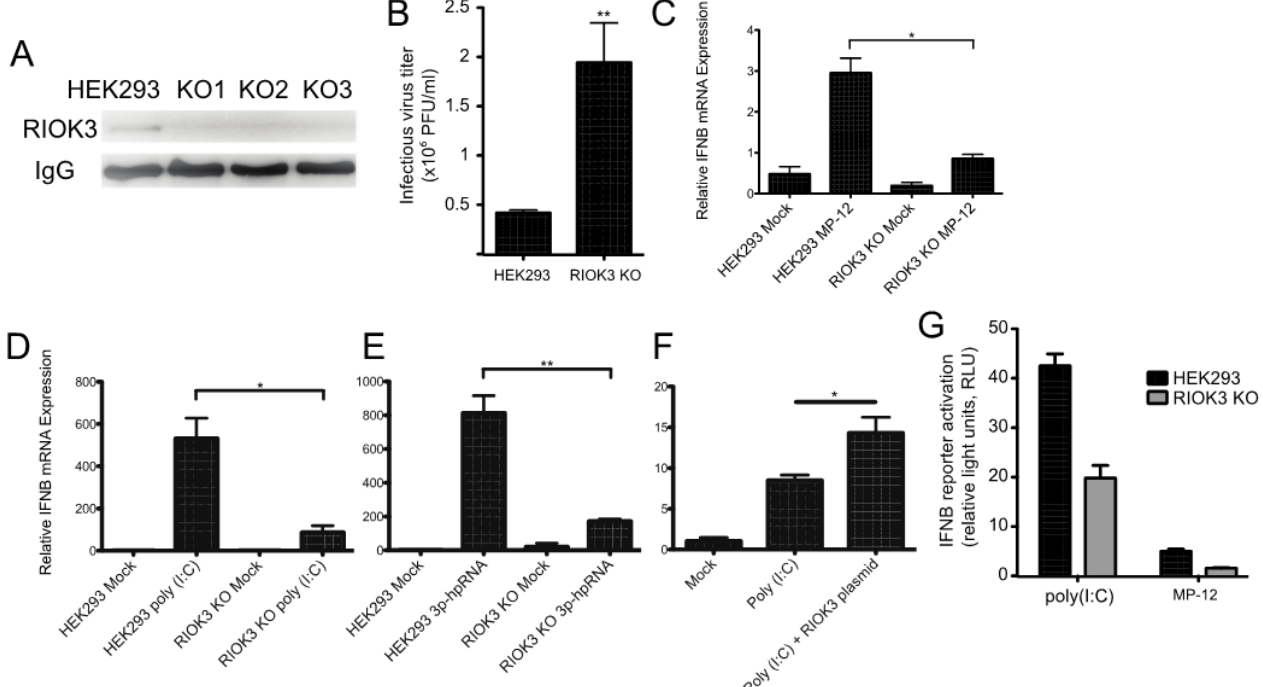
Figure 2. RIOK3 is involved in the signal transduction of the type I IFN response. ( A ) HEK293 cells and three RIOK3 KO cell lines were screened for RIOK3 protein expression by IP-Western blot. ( B ) HEK293 cells and RIOK3 KO cells were infected with MP-12 (MOI 1.0). The viral titer in the 24 hpi supernatant was quantified by plaque assay. ( C , D ) RT-qPCR targeting IFNB was performed on RNA from HEK293 cells and RIOK3 KO cells infected with MP12 ( C ) or treated with poly (I:C) ( D ) or 3p-hpRNA ( E ) for 18 hours. ( F ) RT-qPCR targeting IFNB was performed on RIOK3 KO cells transfected with a GFP (mock) or RIOK3 expression plasmid and treated with poly (I:C) 18 hours later. ( G ) Effect of RIOK3 KO on IFNB promoter activation. HEK293 cells and RIOK3 KO cells were co-transfected with pGL3-IFNB firefly reporter and phRL-CMV renilla control. Cells were stimulated with poly (I:C) or infected with MP-12 and the dual luciferase signals were measured after 18 or 48 h, respectively. In panels B–F, data are presented as mean +/− SEM from three biological replicates. Western blots in panels A is representative of duplicate experiments. Student’s t-test: ** p < 0.01, * p < 0.05.